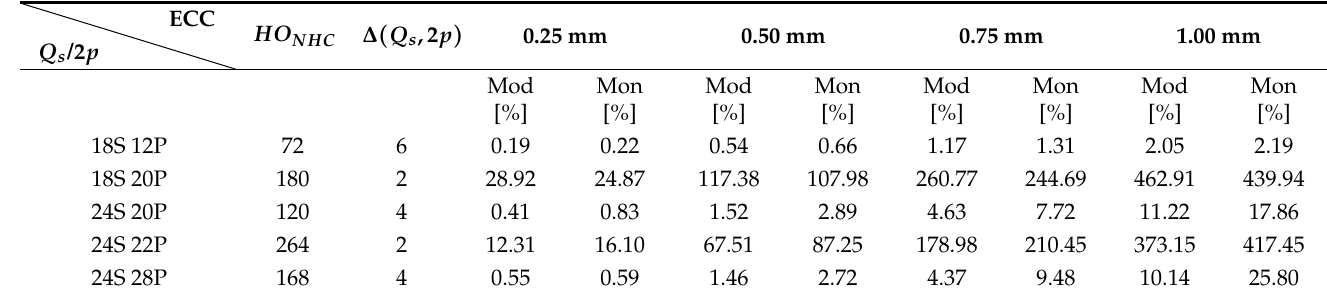
Table 13. Relative cogging torque increase of different PMSM and MPMSM slot/pole combinations in the presence of